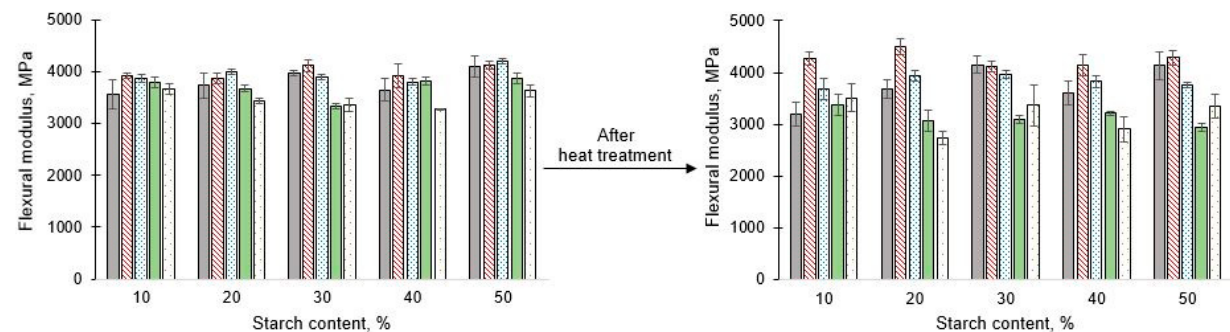
Figure 9. Flexural modulus of unconditioned and conditioned PLA/starch blends.